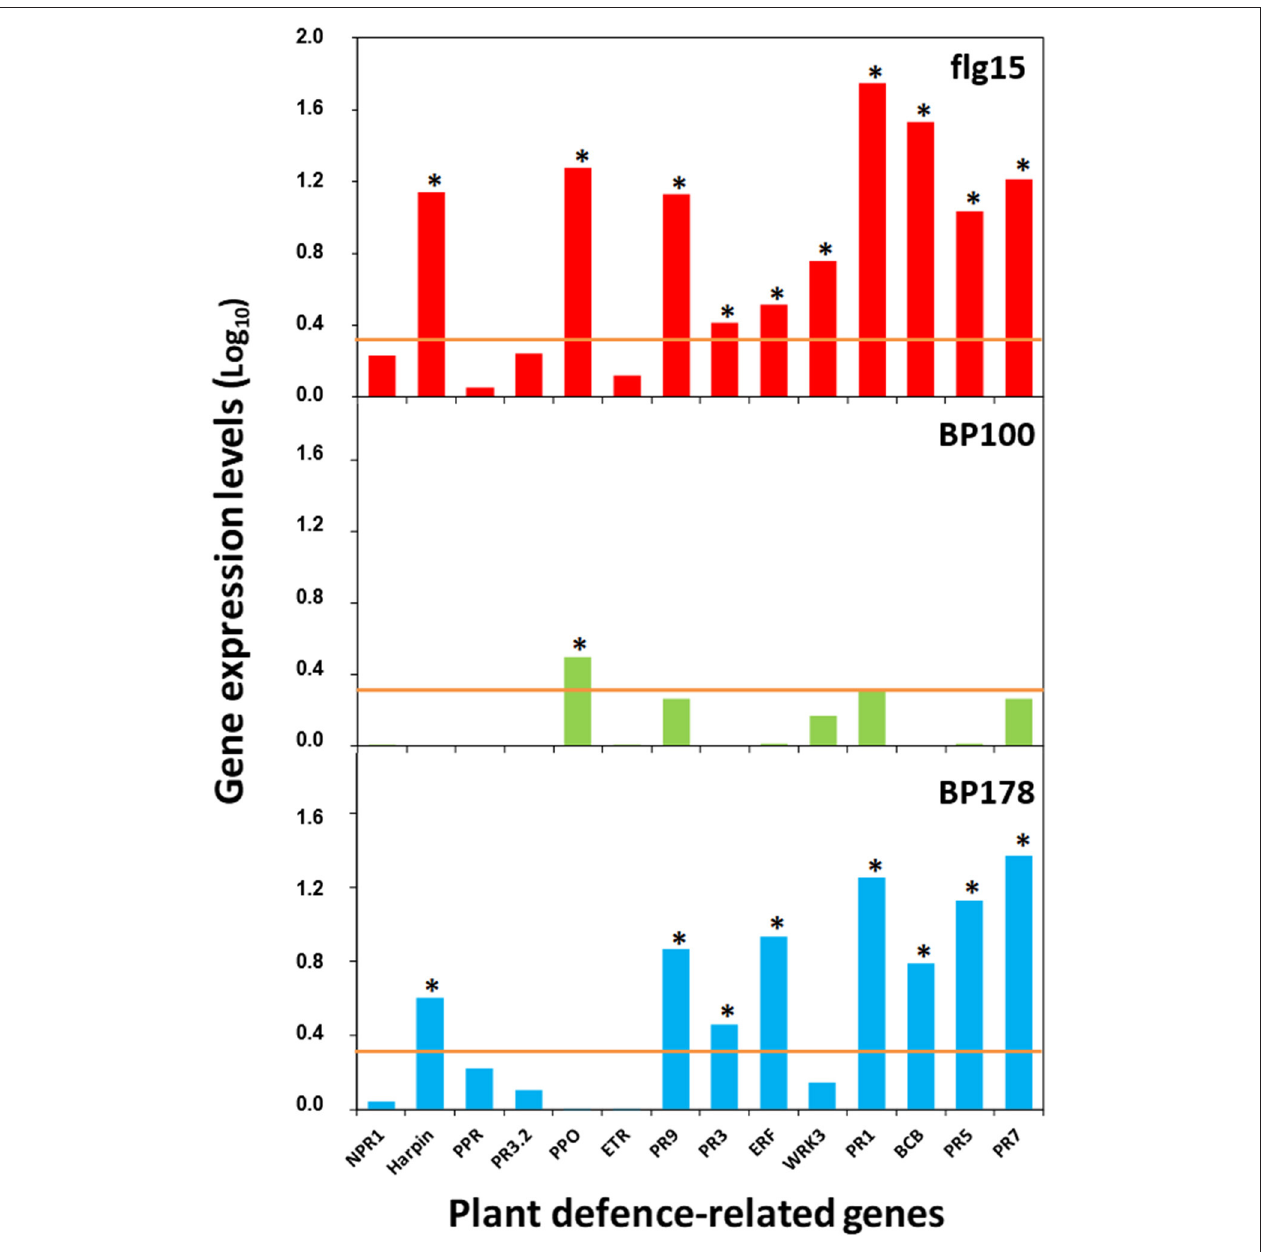
FIGURE 4 | Relative expression levels (log 10 ) of selected tomato plant-defense genes verified by qPCR analysis after treatment with the peptides. Orange line, cut-off values for gene induction are considered fold changes above 2 (log 10 , 0.3) (relative quantification using the 11 Ct method). Asterisk, significant values of fold change. Gene expression data for BP100 and flg15 in the case of PR1 gene have been previously published (Badosa et al.,